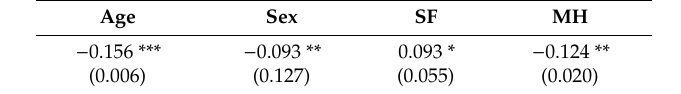
Table 3. Model 1. Dependent variable (entrepreneurial attitude). Independent variables: age, sex, level of studies, professional activity, and health.